Question: How would you classify this visualization?
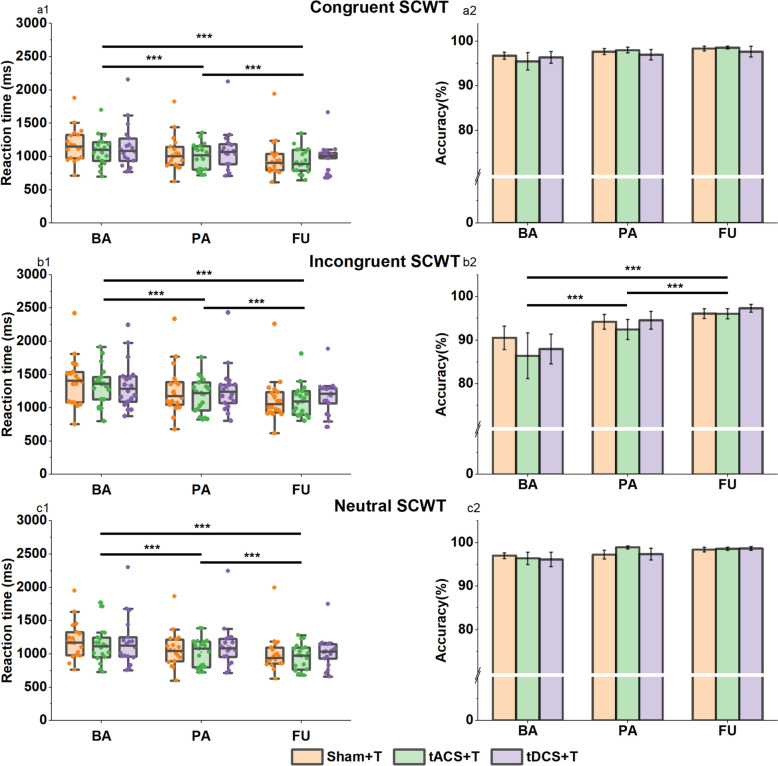
Answer: box